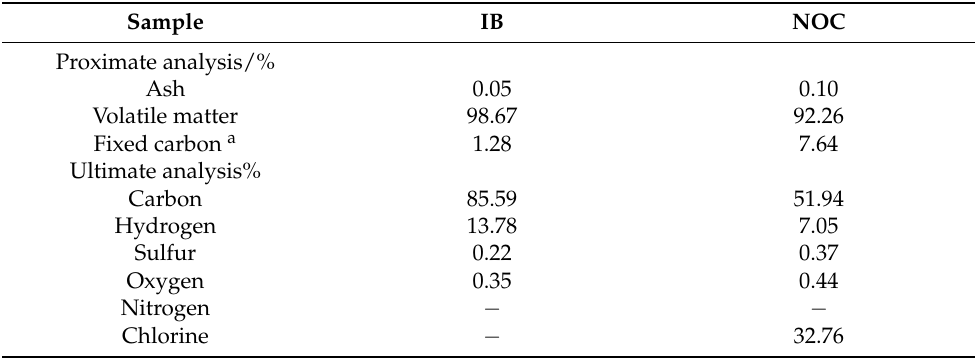
Table 1. Proximate analysis and ultimate analysis of